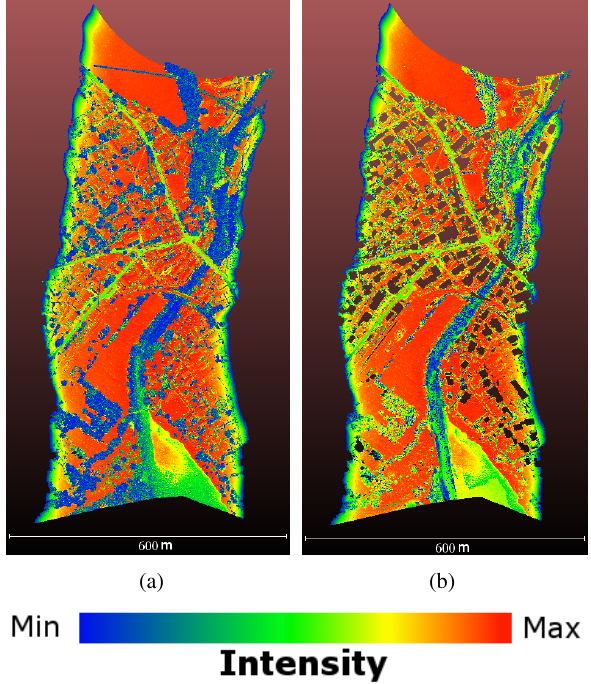
Figure 7. Manually labelled Ground Truth. (a): complete point cloud, (b): ground